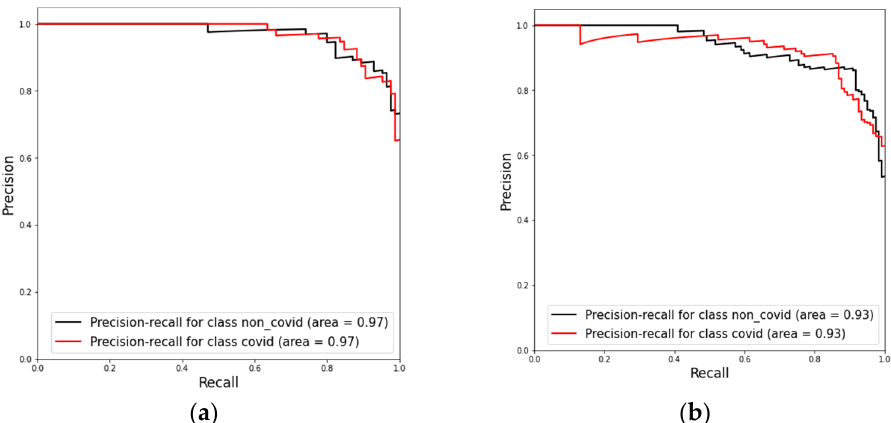
Figure 8. ROC curves obtained for model evaluation on the test dataset 1 ( a ) and on the test dataset 2 ( b ).